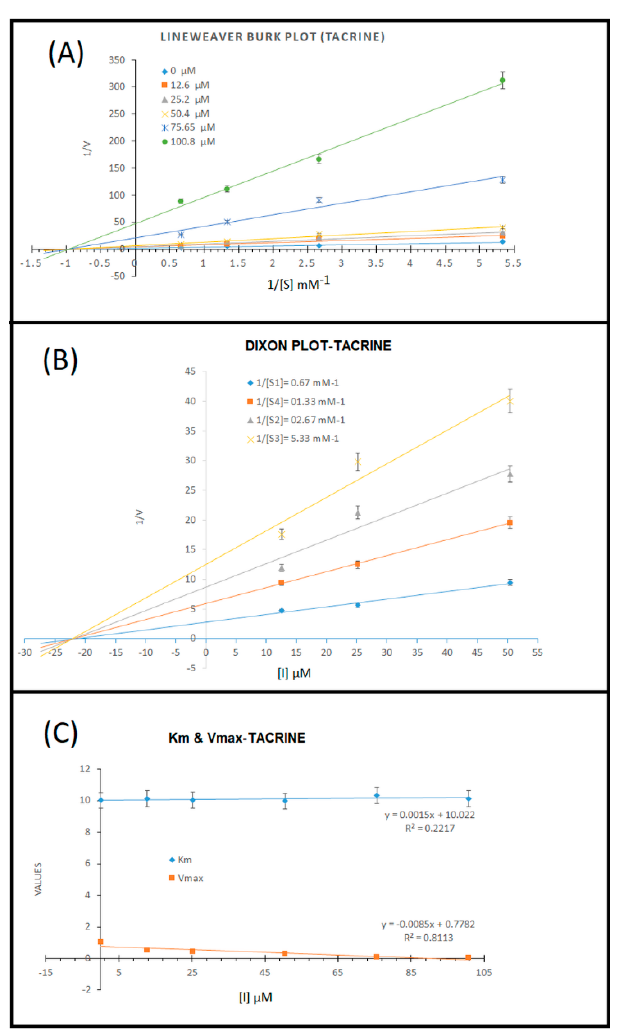
Figure 4. Kinetic analysis results for reference molecule tacrine. ( A ) Lineweaver ‐ Burk plots for the inhibition of AChE in the presence of compound tacrine; concentrations of tacrine were 0, 2.5, 5, 10, and 20 μ g/mL. Substrate (acetylcholine) concentrations were 0.187, 0.375, 0.75, and 1.5 mM; ( B ) Dixon plot; and ( C ) variations in Km and Vmax at different concentrations of tacrine.